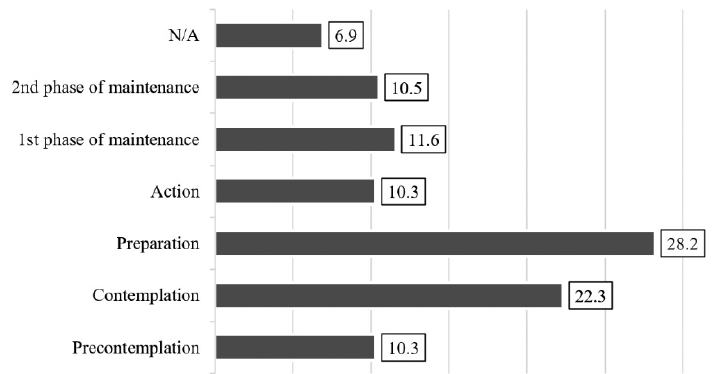
Figure 4. Perception of the individual’s transition to healthier nutrition, % ( n = 612).